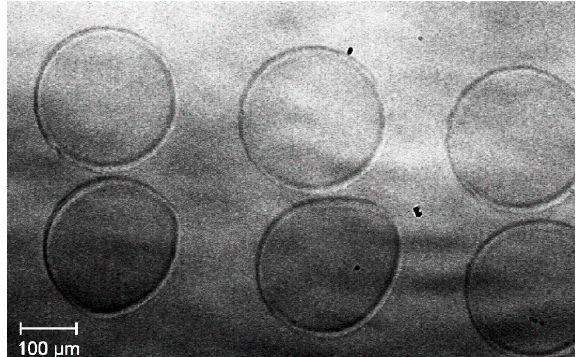
Figure 9. Optical microscopy image of the minimal dot size achievable with the given setup consisting of printer, printhead, and ink- 1. The nominally printed dots are from left to right 100, 110, and 120 µm in diameter and all show the same printed size (Ø = 220–230 µm) on the substrate.